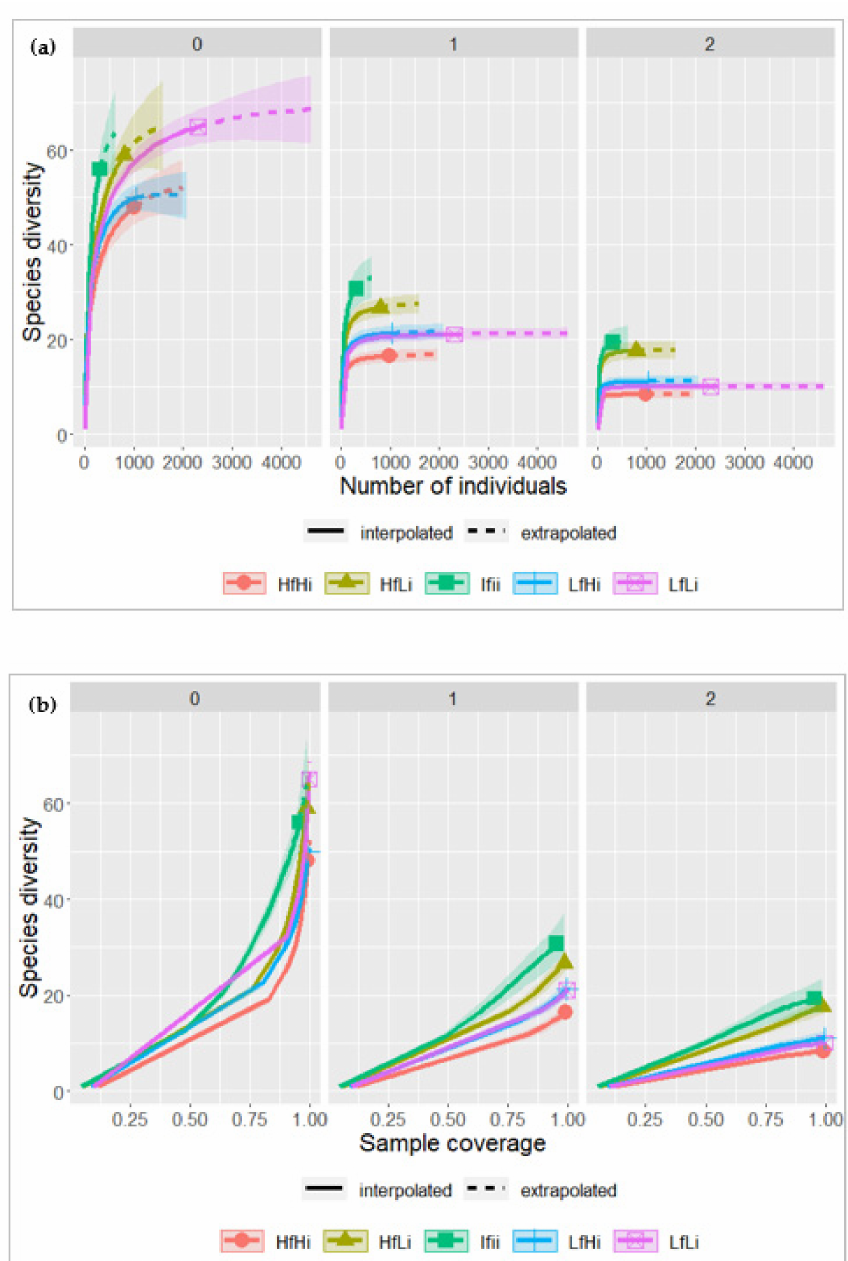
Figure 6. Rarefaction curves according to the number of individuals ( a ) (95% confidence intervals); and respective sample coverage ( b ) under the different fire regimes. Hill numbers (effective number of species): richness ( q = 0), Shannon’s Index ( q = 1), and Simpson’s Index ( q =